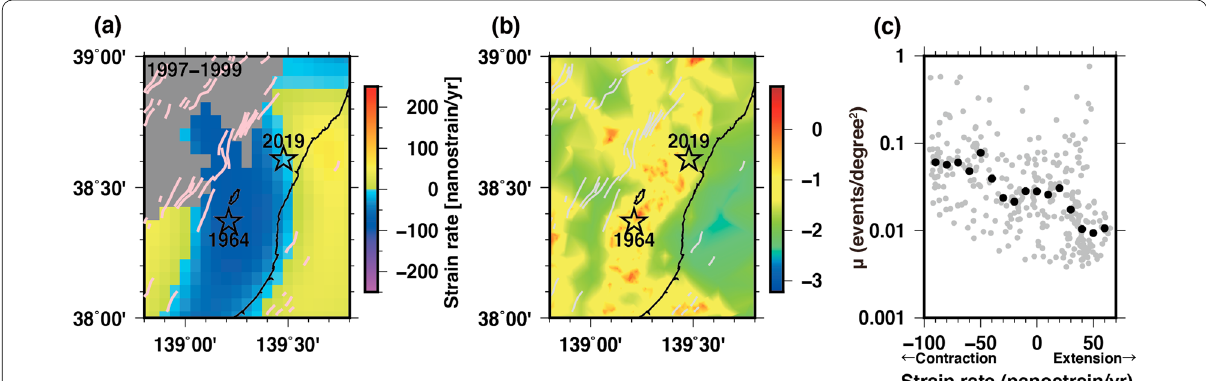
Fig. 3 Comparison between the strain rate and background seismicity rate. a Short-wavelength features from the E–W strain rate before the 2011 Tohoku earthquake (modified from ( e ) of Menesses-Gutierrez and Sagiya (2016)) Negative strain rate indicates contraction. The two black stars denote the epicenters of the 1964 Niigata (lower) and 2019 Yamagata-Oki (upper) earthquakes. b Common logarithm of the background seismicity rate ( µ -values) (same figure as Fig. 2a). Gray lines mark the surface traces of active Quaternary faults. c Correlation between the background seismicity rate ( µ -values) and E–W strain rate. Black points are median value of µ in each 10-nm/year-strain-rate